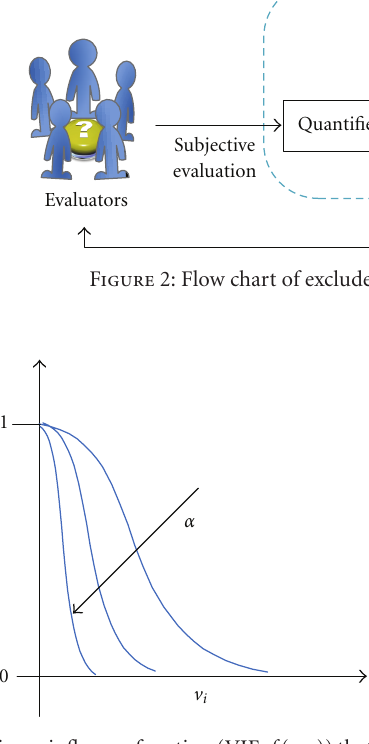
Figure 3: A variance influence function (VIF, f ( αv i )) that decreases exponentially with increasing excluded-variance v i . The gain α rep- resents the importance of the variance, (3). As α increases, the slope of the VIF becomes